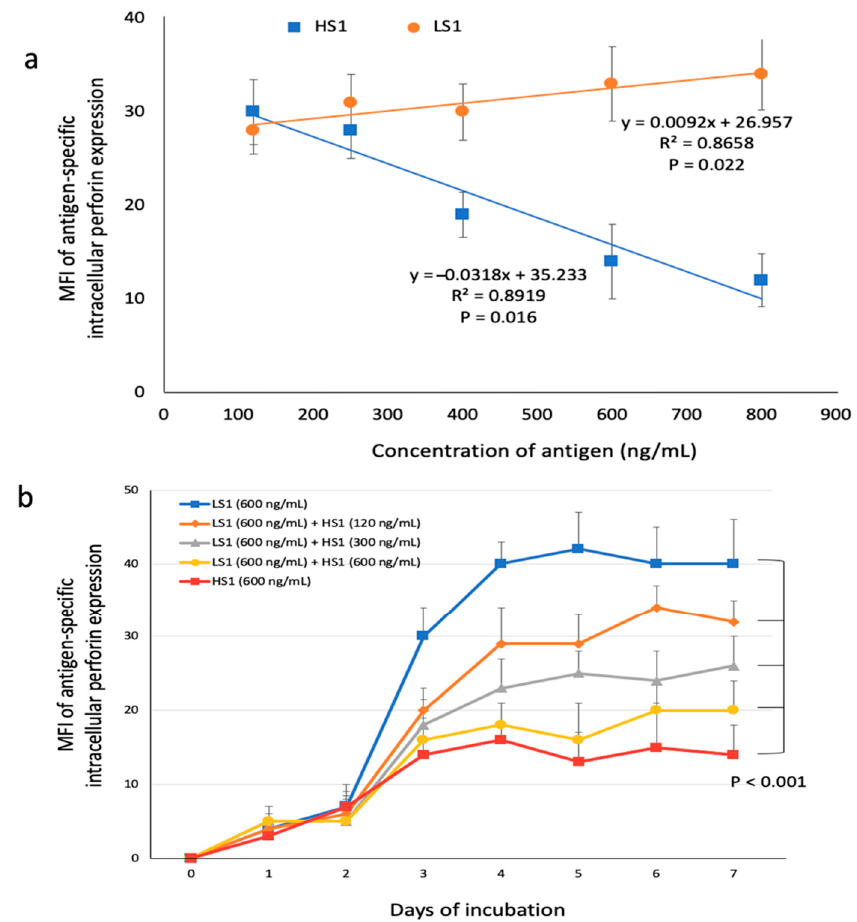
Figure 4. Suppression of intracellular perforin expression in CD8+ T cells by S1-presenting DCs. ( a ) Dose-related responses of mean fluorescence intensity (MFI) of antigen-specific intracellular perforin expression in CD8+ T cells were determined on day three of co-incubation with autologous DCs pulsed with variable doses of HS1 (S1 of SARS-CoV-2) or LS1 (S1 of HCoV-HKU1). Data are presented as mean + SD among 10 subjects. Linear correlation was evaluated using Pearson’s correlation coefficients. ( b ) Mixed S1 experiments to assess the impact of variable doses of HS1 on intracellular perforin expression in CD8+ T cells incubated with autologous DCs simultaneously pulsed with LS1 (600 ng/mL) and variable doses of HS1. Data are presented as mean + SD among 10 subjects. Statistical significance was determined using a repeated-measures one-way ANOVA.